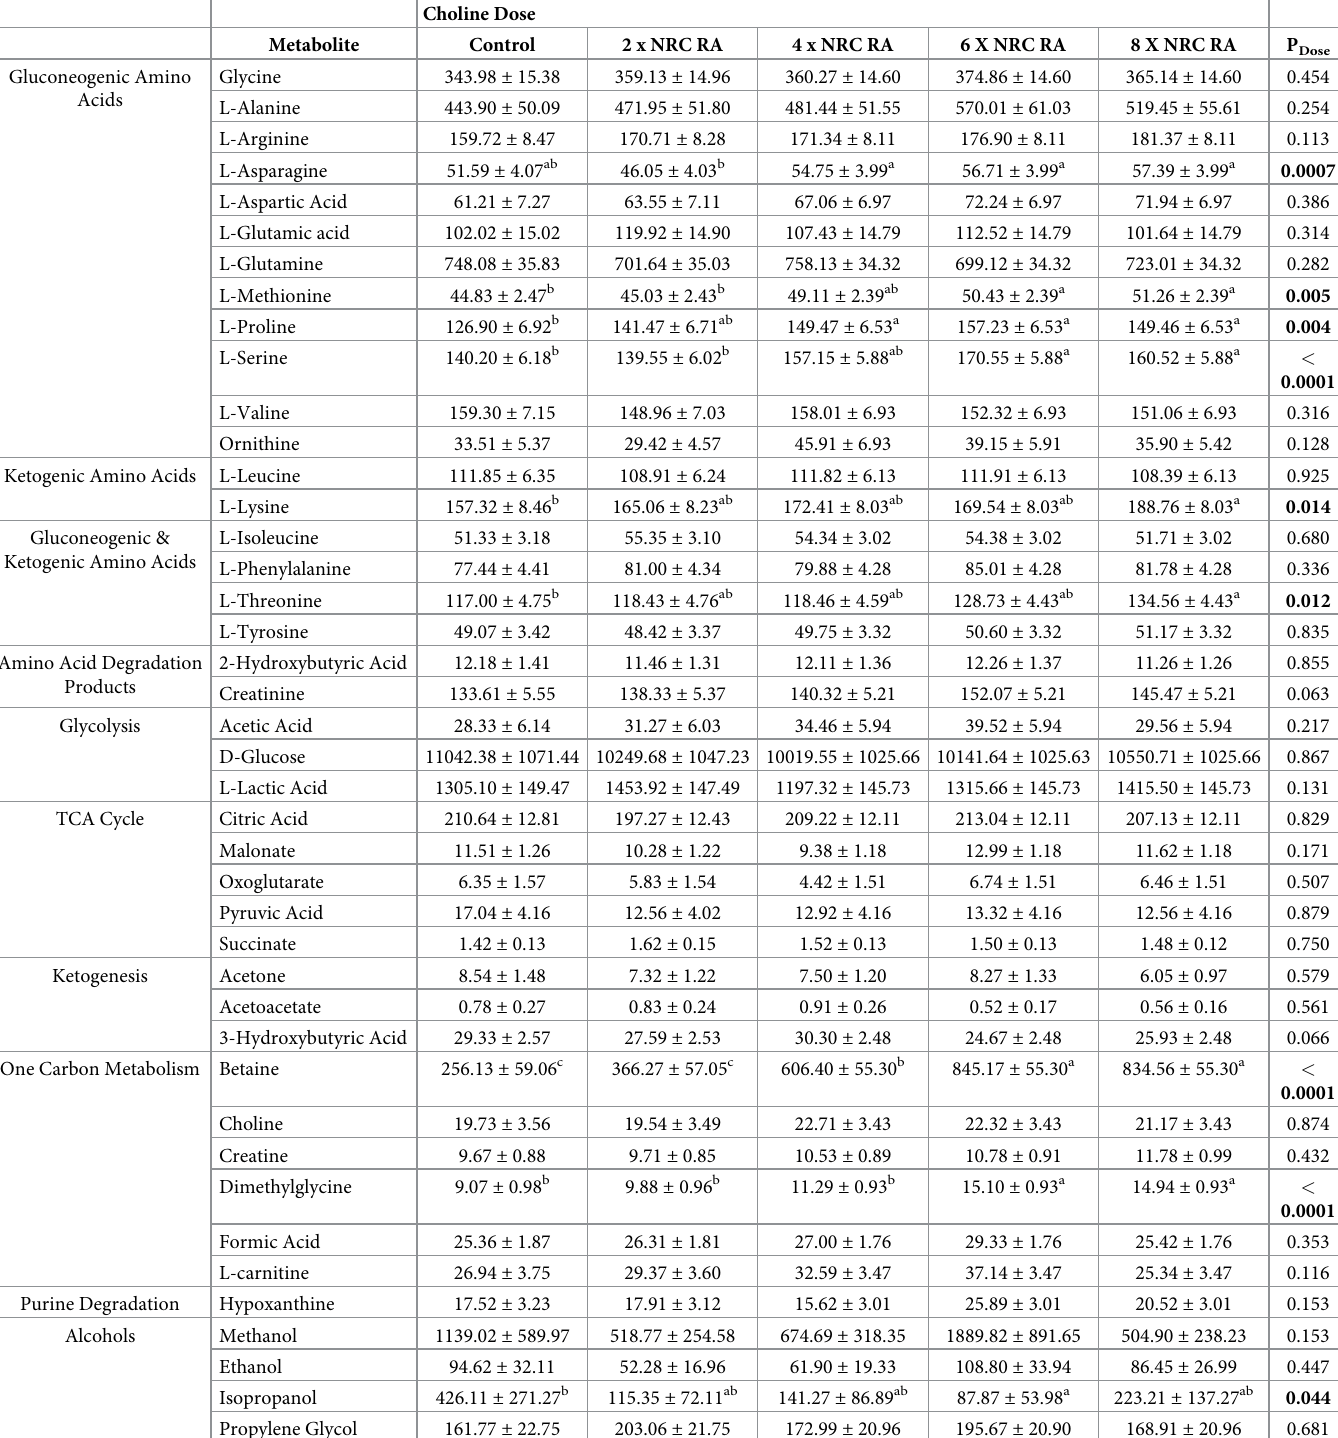
Table 1. Mean serum concentrations ( μ M) of metabolites determined by quantitative NMR spectroscopy in overweight cats (n = 14) receiving control (no additional choline supplementation, 1.2 x NRC RA, 77 mg/kg BW 0.67 ), choline at 2 x NRC RA (126 mg/kg BW 0.67 ), 4 x NRC RA (252 mg/kg BW 0.67 ), 6 x NRC RA (378